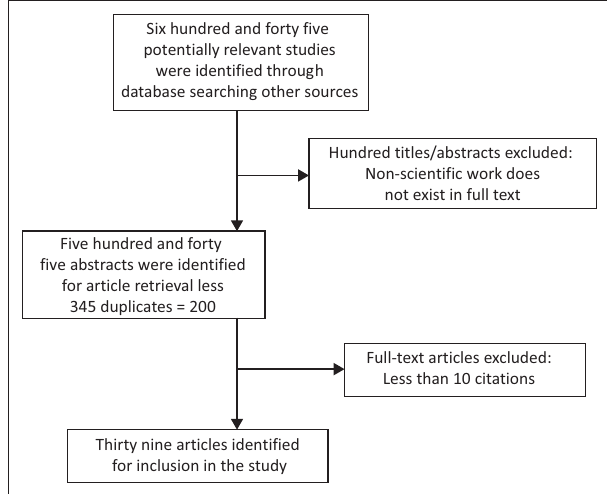
FIGURE 1: Preferred reporting items for systematic review and meta-analysis flow diagram for the retrieval of relevant